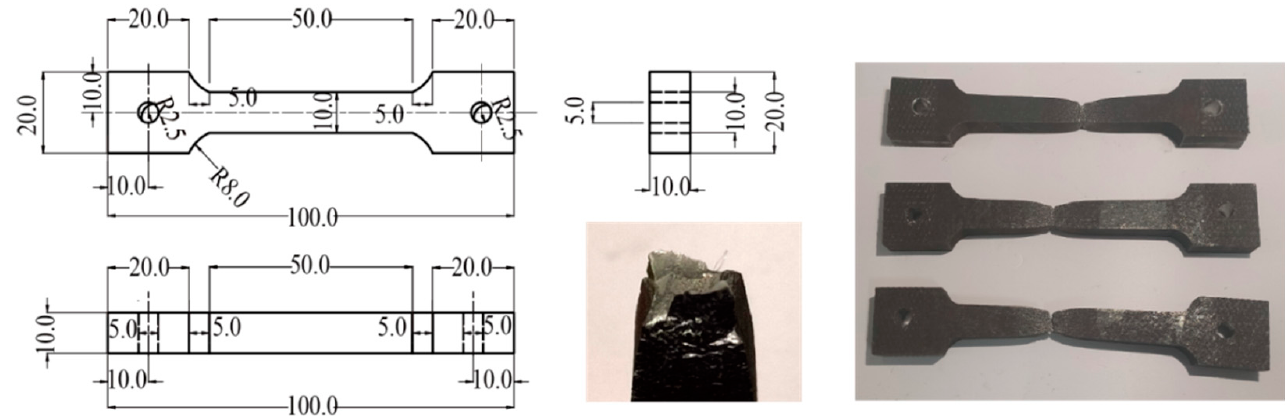
Figure 11. Ni-Fe tensile specimen dimensions and damage specimen diagram(unit: mm).